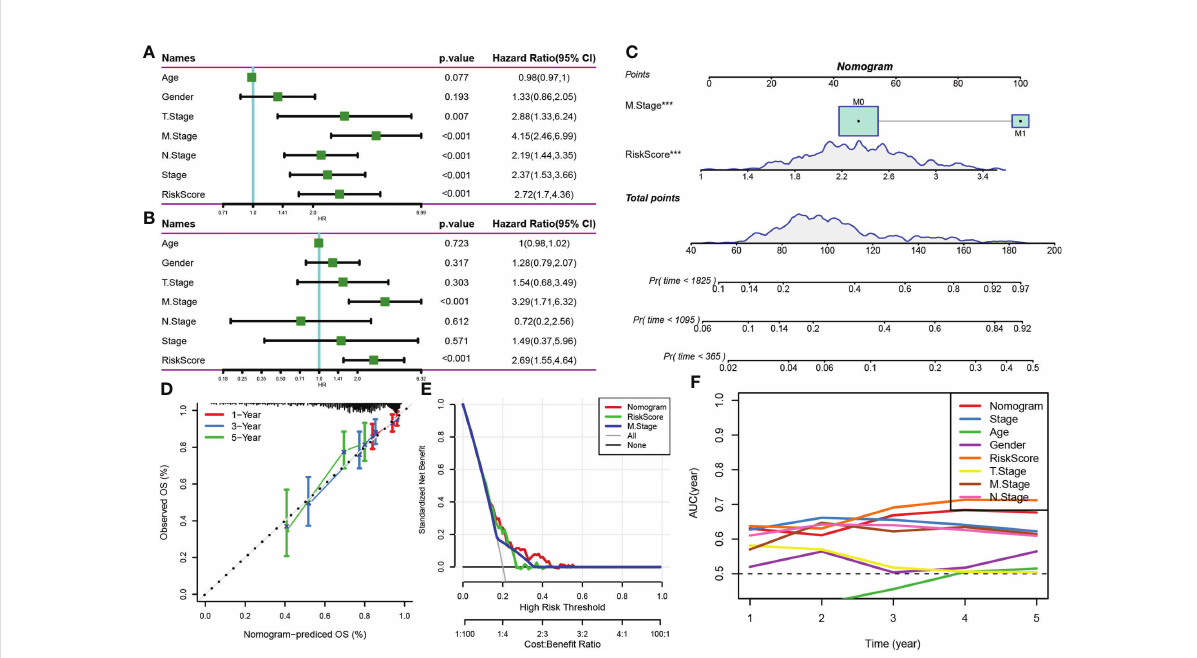
FIGURE 9 (A, B) Univariate and multivariate Cox analyses of the risk score and clinicopathological features; (C) Nomogram model; (D) Calibration curve of the nomogram (1, 3 and 5 years); (E) Decision curve of the nomogram; (F) Compared with other clinicopathological features, the nomogram exhibited a superior capacity for survival